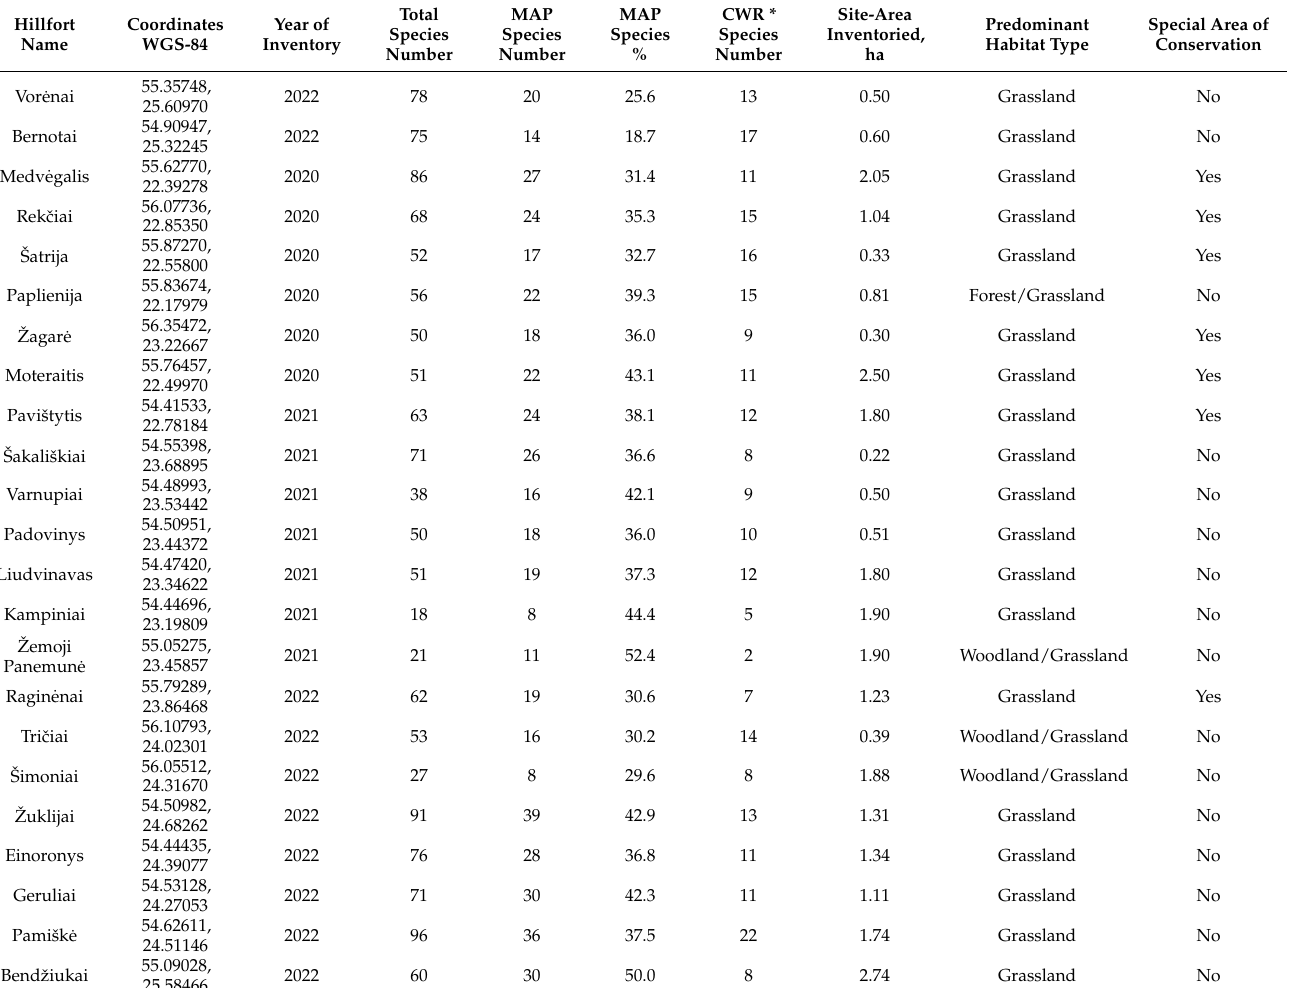
Table 1. Major characteristics of hillfort sites studied and number of species